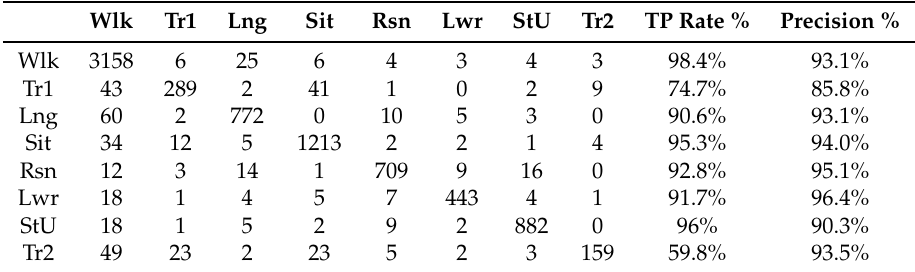
Table 1. Confusion matrix for activities.